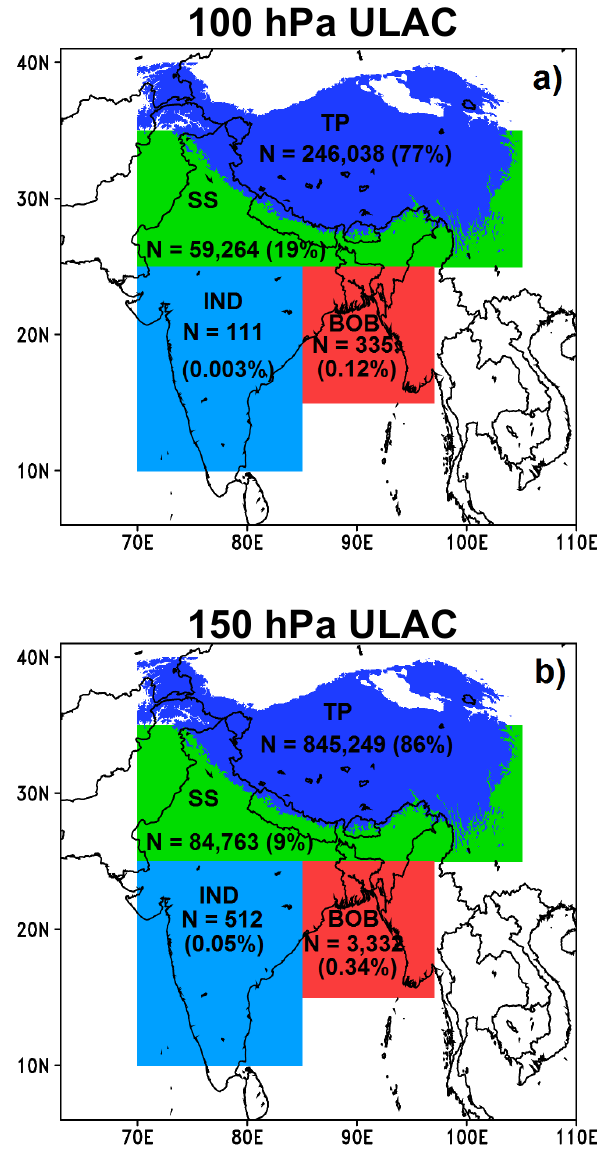
Fig. 7. The number and percentage of back trajectories starting at the ULAC at 100hPa (a) and 150hPa (b) that crossed the PBLH in each region of interest (the convectively influenced